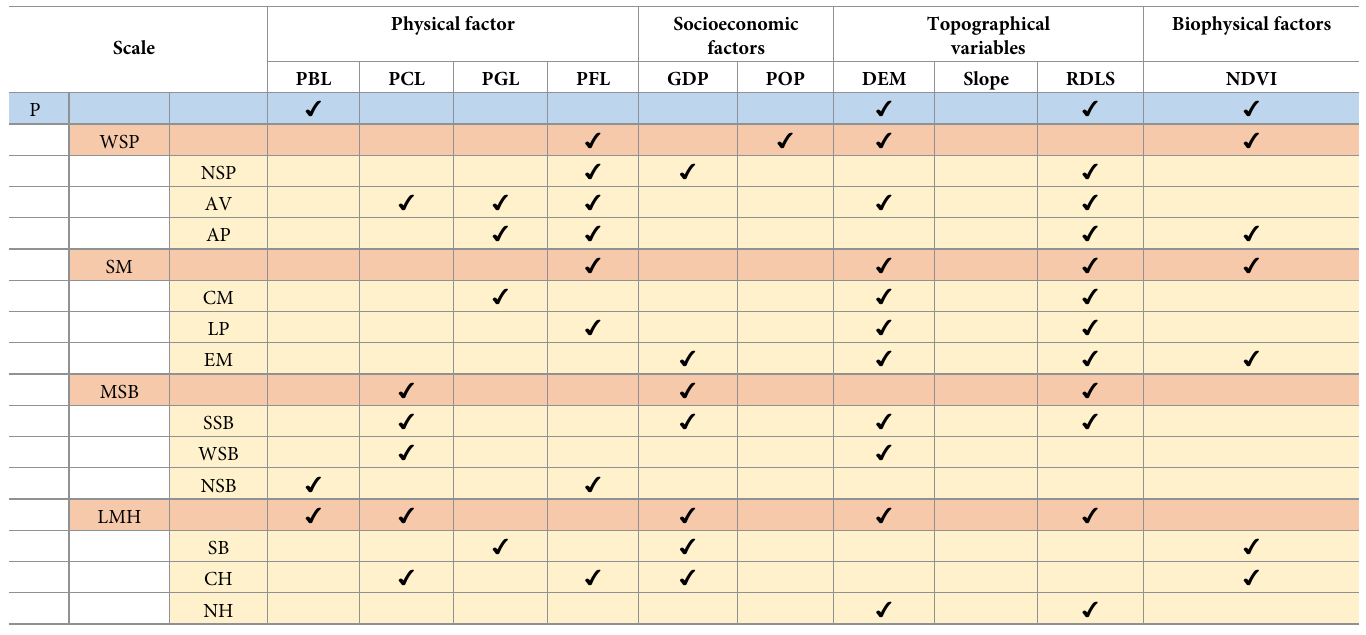
Table 5. The associations between environmental factors and the local regression coefficients of water yield at the provincial (P) scale, ecoregion (E) scale, and sube- coregion (SE) scale (p < 0.05).